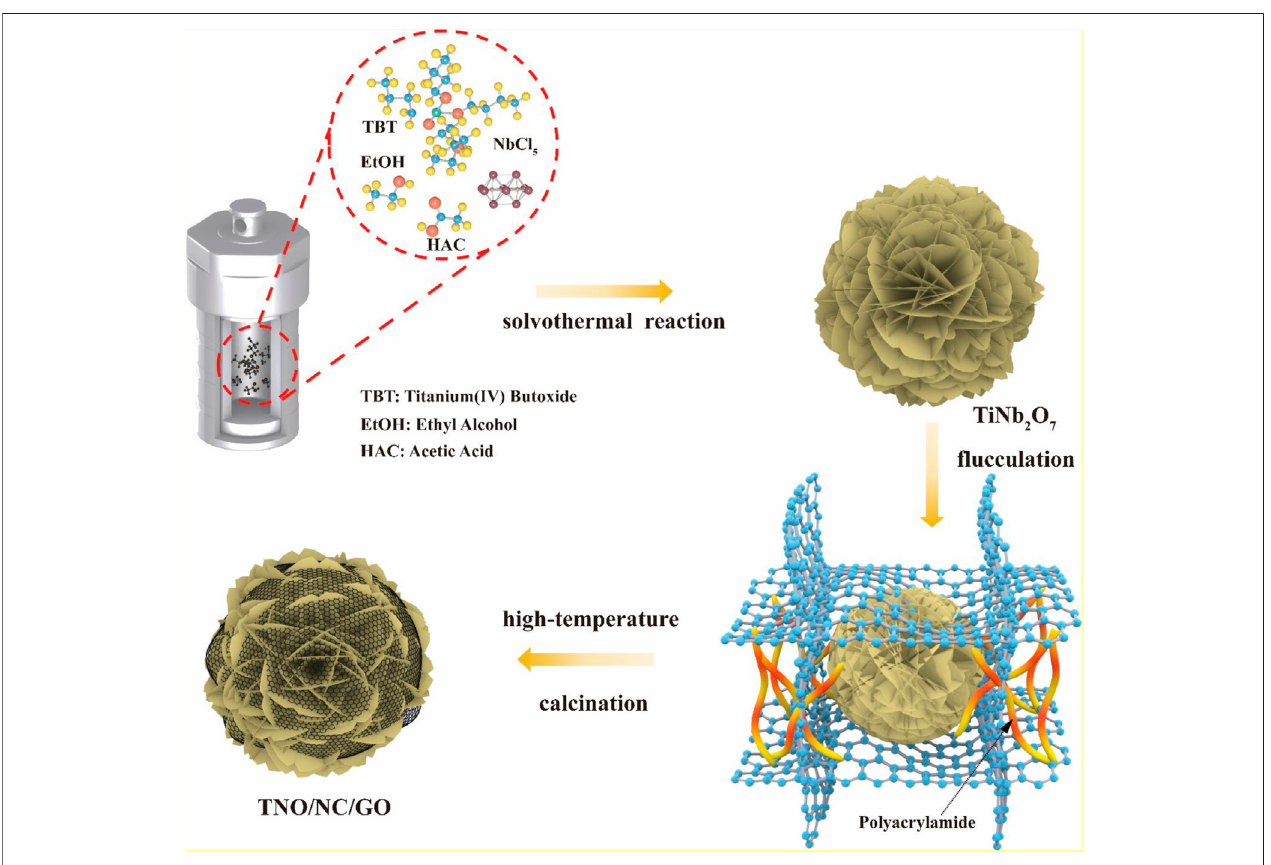
FIGURE 1 | Schematic process of the formation of TNO/NC/GO composite.